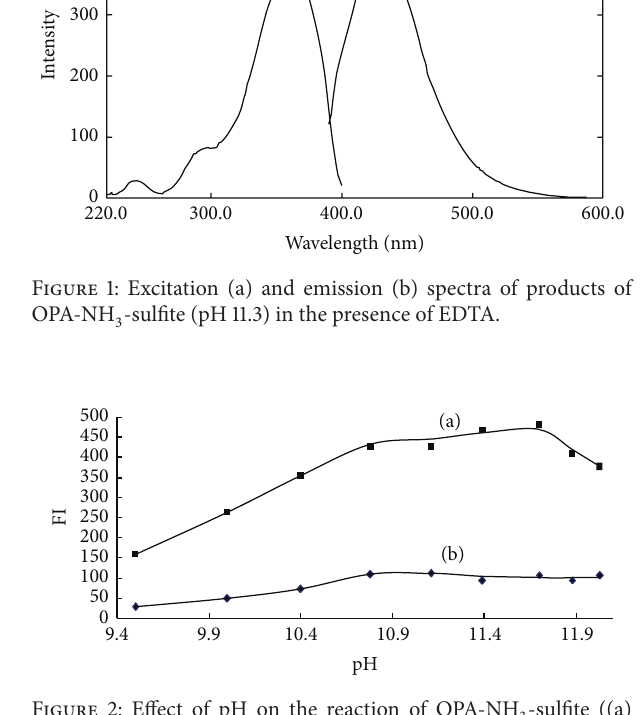
Figure 2: Effect of pH on the reaction of OPA-NH 3 -sulfite ((a) 0.25 𝜇 mol/L, (b)